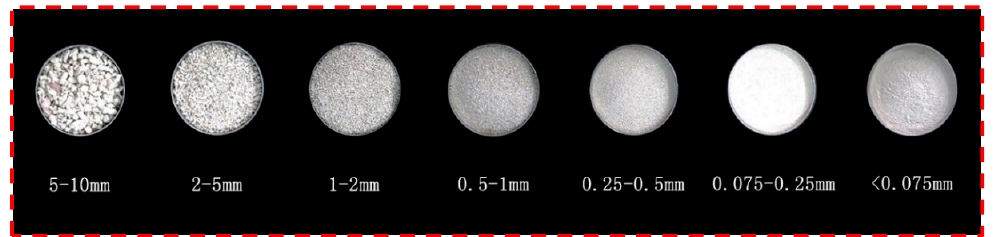
Figure 3. Fractions of coral sand.